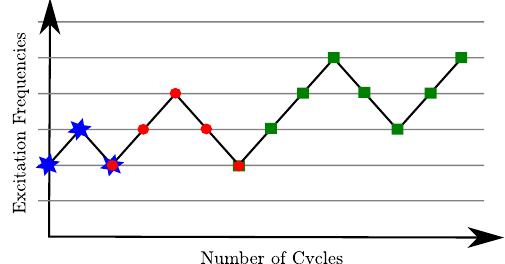
Figure 2. Scheme of a cyclic multi-stage full-waveform inversion with three full cycles ( (cid:70) 1st cycle, • 2nd cycle, (cid:4) 3rd